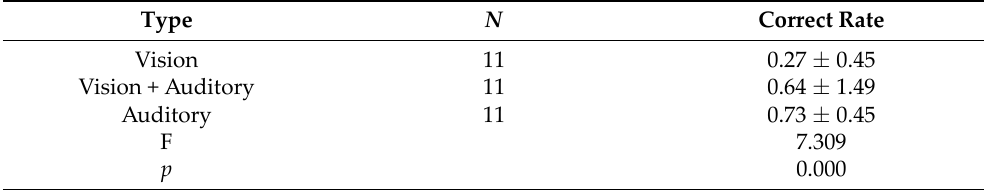
Table 9. Results of the DUNCAN post‑test multiple comparisons of response time and correctness of multi‑sensory message prompting